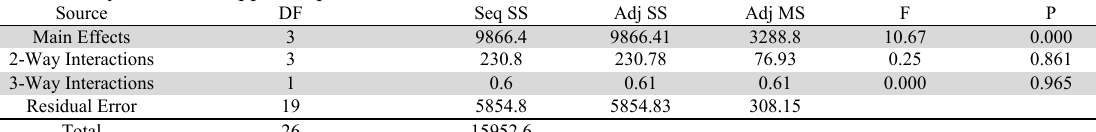
Variance analysis for the supplier’s profit Source